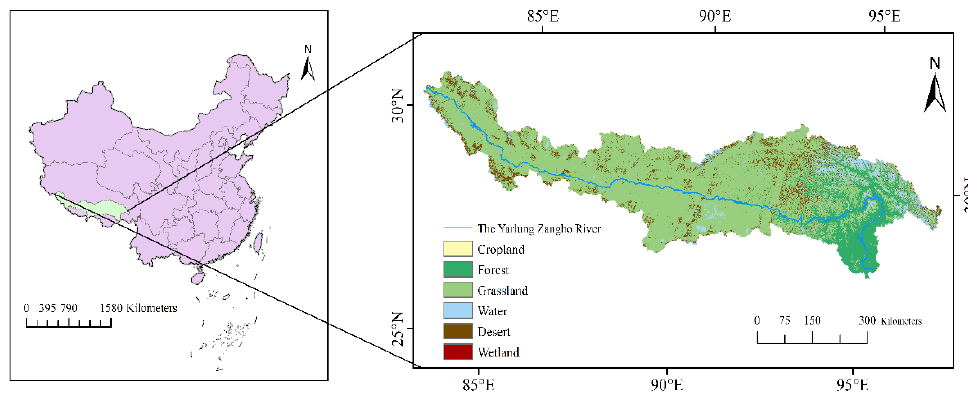
Figure 1 . Location and land-use types in the study area. Figure 1. Location and land-use types in the study